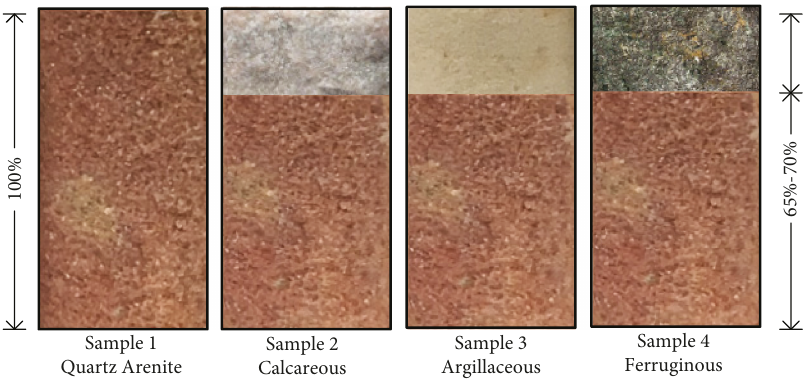
Figure 1: Diagram showing the di ff erence in the mineralogy of the sandstone core samples for this work.